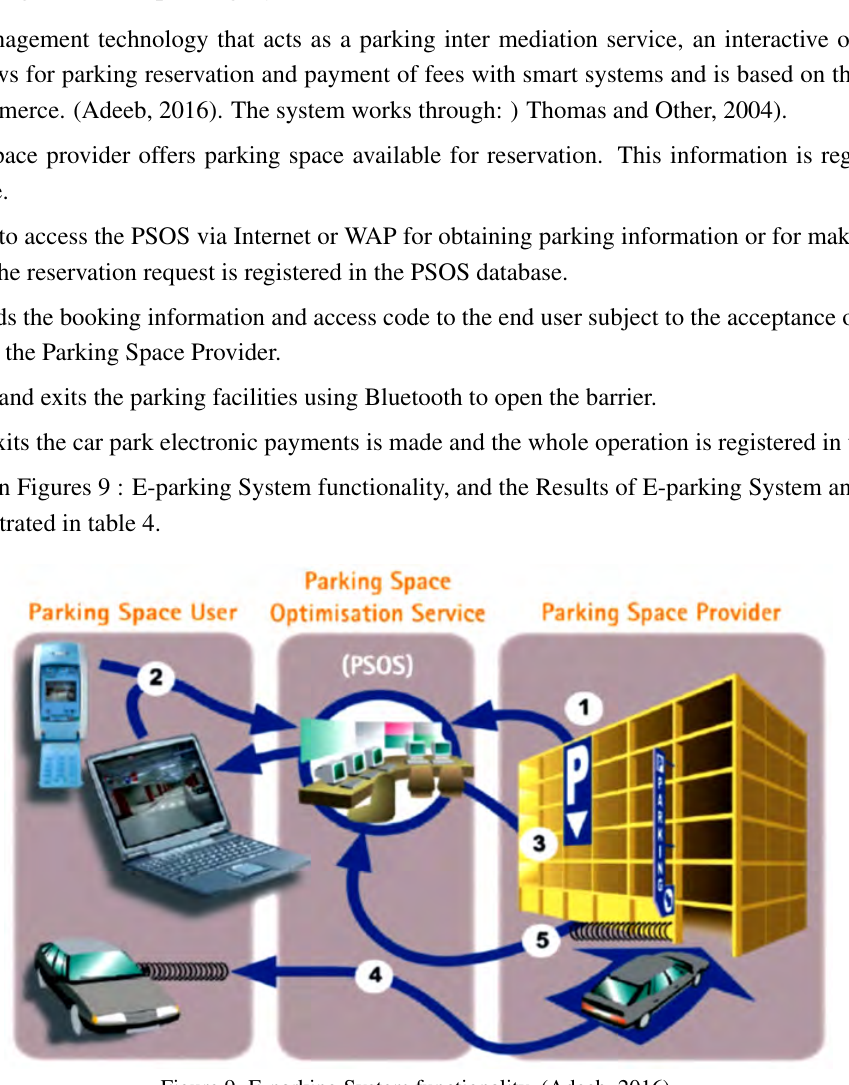
Figure 9. E-parking System functionality. (Adeeb, 2016).